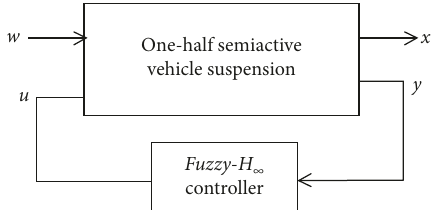
Figure 6: Semiactive suspension system (disturbance